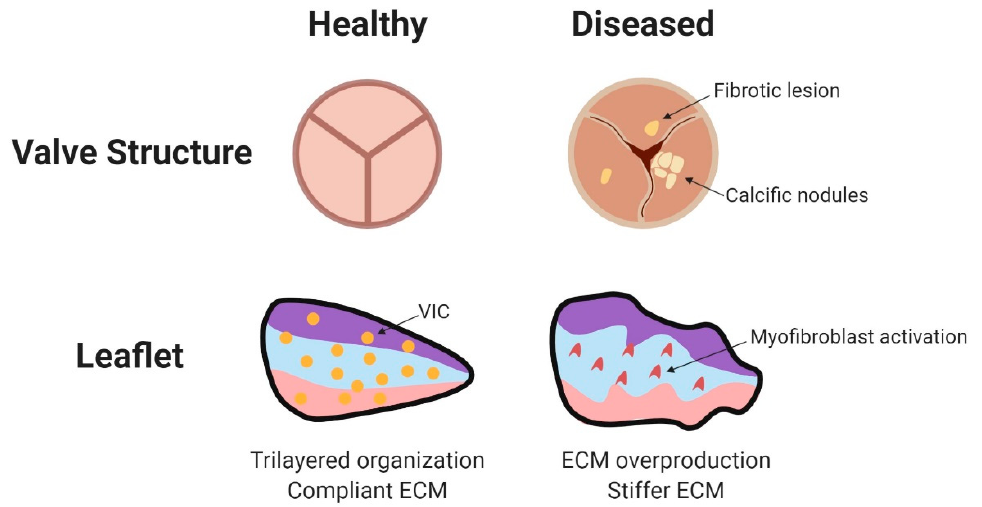
Figure 4. Disease pathology of adult valves. Diseased valves may exhibit calcification and fibrotic lesions. Accumulating pathology leads to leaflet calcification, valvular insufficiency, valvular stenosis, and increased cyclic wall strain. Within the valve leaflets, VICs transform to activated myofibroblasts. The increased production of collagen, elastin, GAGs, and matrix metalloproteases changes the architecture of the leaflet. Major mechanosensors in valvular endothelial cells include ECM components, Wnt and TGF- β signaling, G protein coupled receptors, cell adhesion molecules, and cytoskeletal components (reviewed in [95]). Figure created using BioRender. Citation for Figure 4: [95].